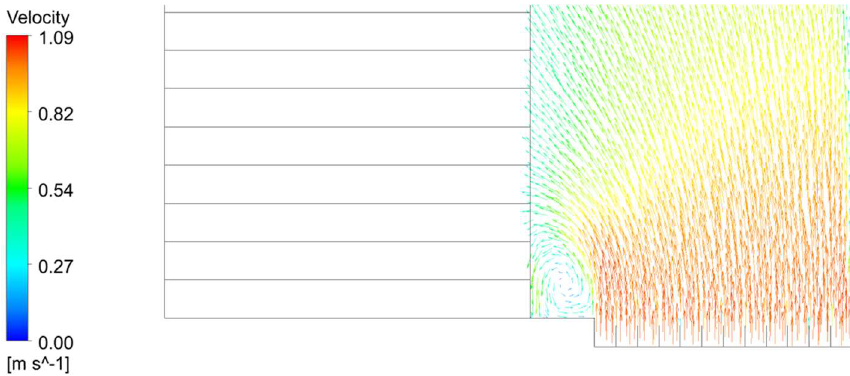
Figure 13. Vortex at the bottom of the rack.